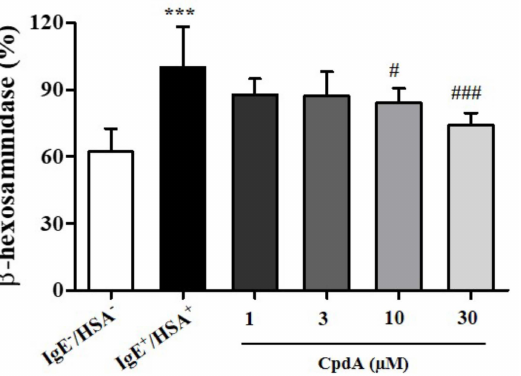
Figure 1. Compound A suppresses antigen-induced degranulation in RBL-2H3 cells. RBL-2H3 cells were sensitized with anti-DNP IgE for 18 h and challenged with DNP human serum albumin (HSA). Compound A was added at the indicated concentrations 30 min before HSA challenge. Samples without IgE and HSA showed basal degranulation, and samples with IgE and HSA showed positive control of antigen-induced degranulation. The results are presented as mean ± standard error (SE) of five independent experiments. *** p < 0.001 vs. the HSA-untreated group. # p < 0.05, ### p < 0.001 vs. the HSA-treated